Question: Identify the chart type used in this figure.
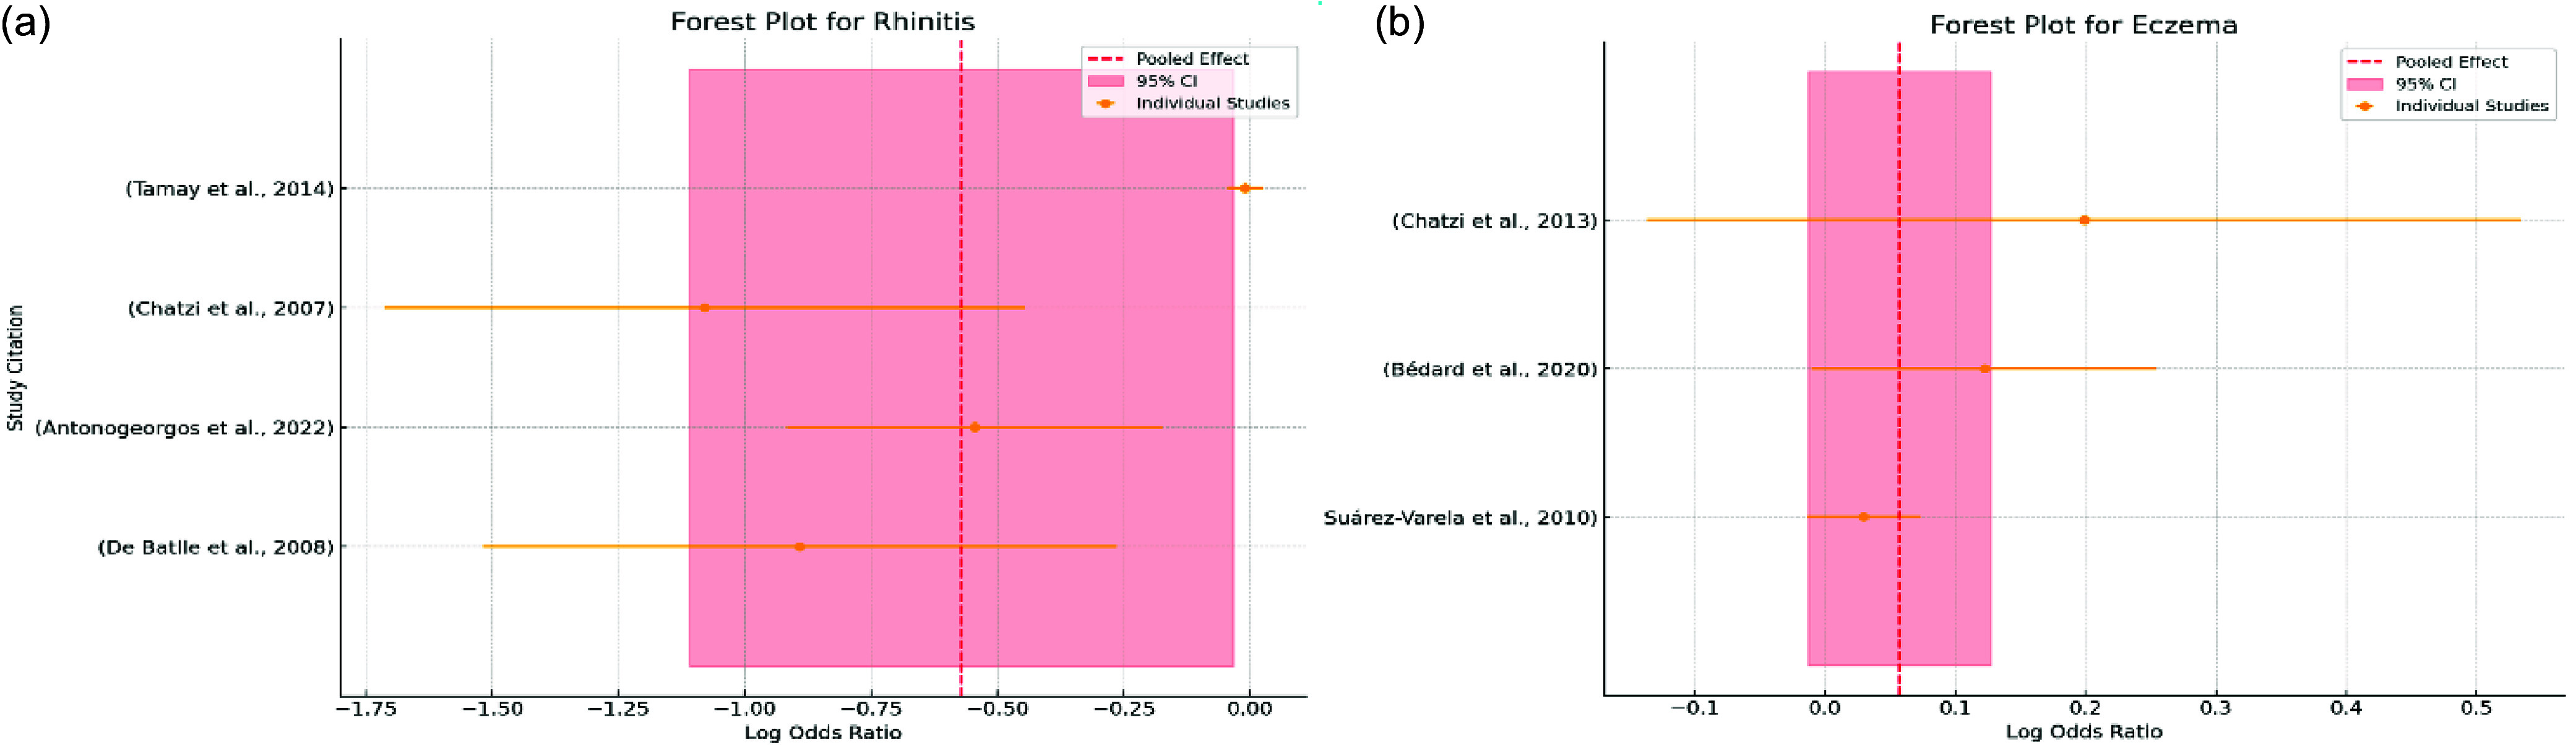
Answer: forest